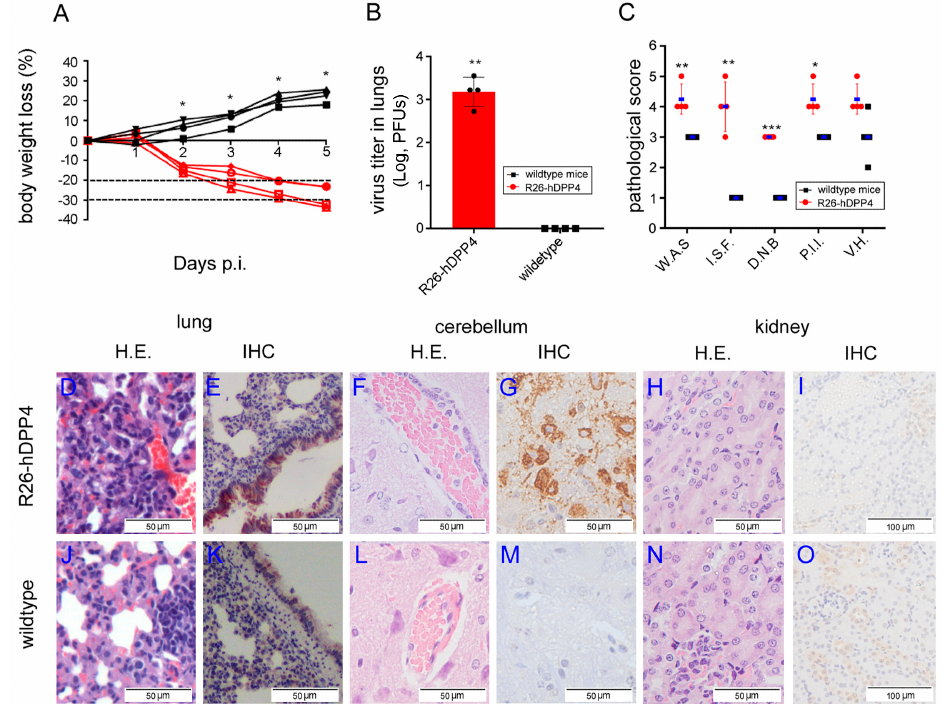
Figure 2. R26-hDPP4-knockin mice were susceptible to infection by authentic MERS-CoV at low dose. ( A ) Weight loss in R26-hDPP4 mice challenged with hCoV-EMC at a dose of 1.5 × 10 5 PFUs. ( B ) Viral titers in lungs of challenged R26-hDPP4 mice on day 5 p.i. LOD (limitation of